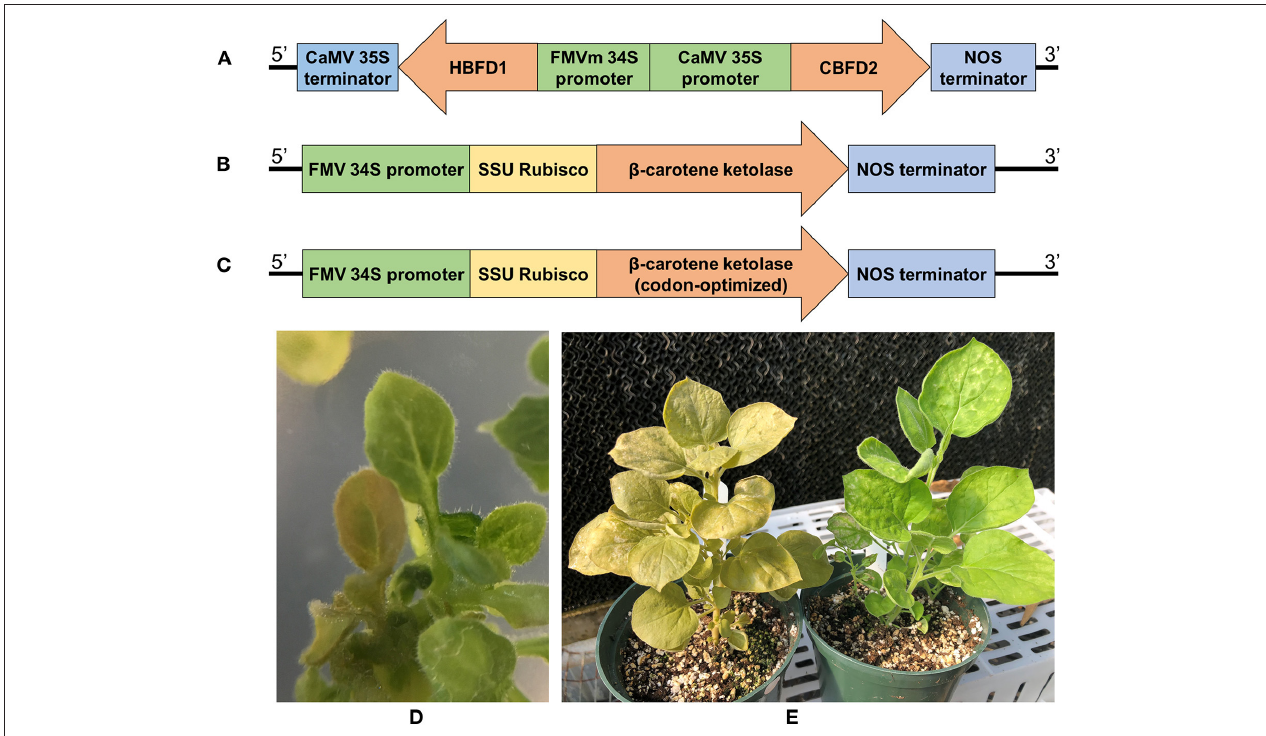
FIGURE 2 | (A–C) Schematic representation of the gene constructs used to induce astaxanthin production in the transgenic plants. All constructs were cloned in pCAMBIA2201 which contains GUS and Kanamycin resistance genes for expression in plants and chloramphenicol resistance for bacterial selection (not shown). (A) pCAMBIA2201-HBFD1-CBFD2 plasmid contains the two astaxanthin inducing chimeric genes, HBFD1 and CBFD2 , from Adonis aestivalis , (B) pCAMBIA2201-crtW plasmid contains the β -carotene ketolase, (C) pCAMBIA2201-Cit/crtW plasmid contains the plant codon-optimized cDNA for β -carotene ketolase. FMVm